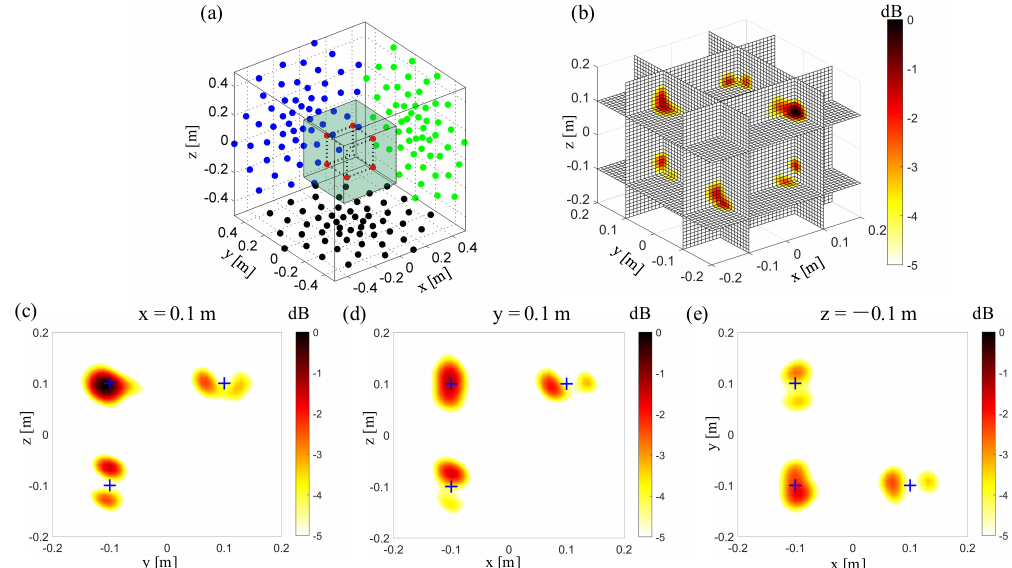
Figure 8. 3D Beamforming results from the non-synchronous measurements, orthogonally moving the array twice. ( a ) The simulation setup. The red points “ · ” represent the sound source. The other same color represents the microphones in the same test. The black points “ · ” represent the microphones in a single planar array test. The blue points “ · ” represent the microphones in the test with the orthogonal moving array, moved here for the first time. The green points “ · ” represent the microphones in the test with the orthogonal moving array, moved for the second time. ( b ) 3D beamforming map. ( c ) The beamforming map at the x = 0.1 m slice. ( d ) The beamforming map at the y = 0.1 m slice. ( e ) The beamforming map at the z = − 0.1 m slice. 3.3. 3D Imaging by the Non-Synchronous Measurements with Non-Orthogonal Moving Arrays